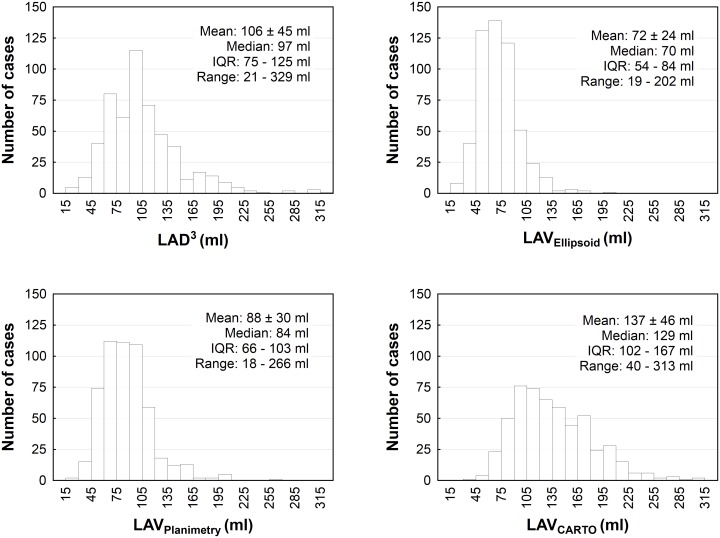
Distribution of left atrial atrial size indices.Abbreviations: IQR—interquartile range; LAD3 –cubed left atrial diameter in parasternal long-axis view; LAVEllipsoid−left atrial volume (LAV) assessed by the prolate-ellipsoid method; LAVPlanimetry−LAV assessed by the planimetric method; LAVCARTO−CARTO-derived LAV.